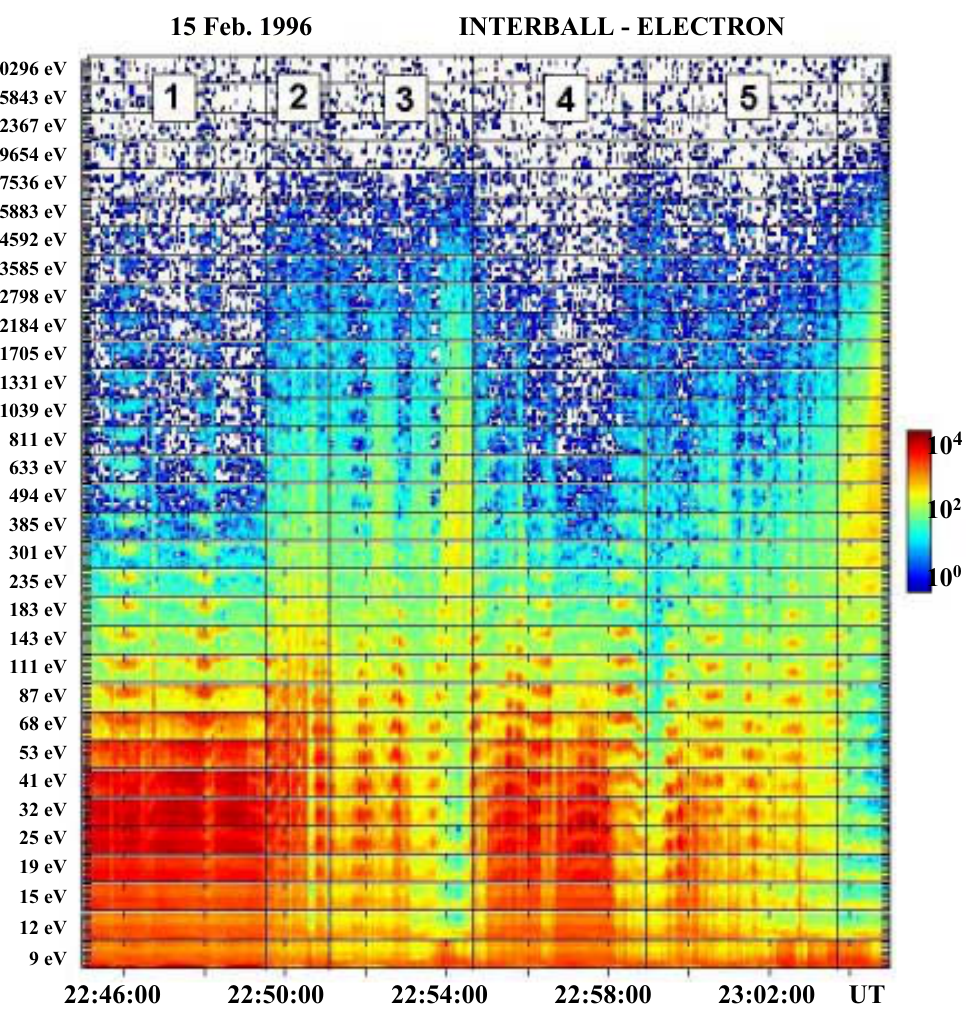
Fig. 3. Energy-time and angular spectrograms are shown for electrons in the time interval of interest on 15 February 1996. Each horizontal panel represents the counting rate of electrons with the energy indicated to the left. The distribution of the counting rate along the ordinate within each energy band shows an angular distribution of electrons in the meridional plane of the satellite, in which the Sun is on the pole. The anti-sunward moving electrons are on the upper part of each panel, and sunward moving electrons are on the lower part of the panel. Three dimensional velocity distribution of electrons is measured within a 2-minute period of the satellite’s